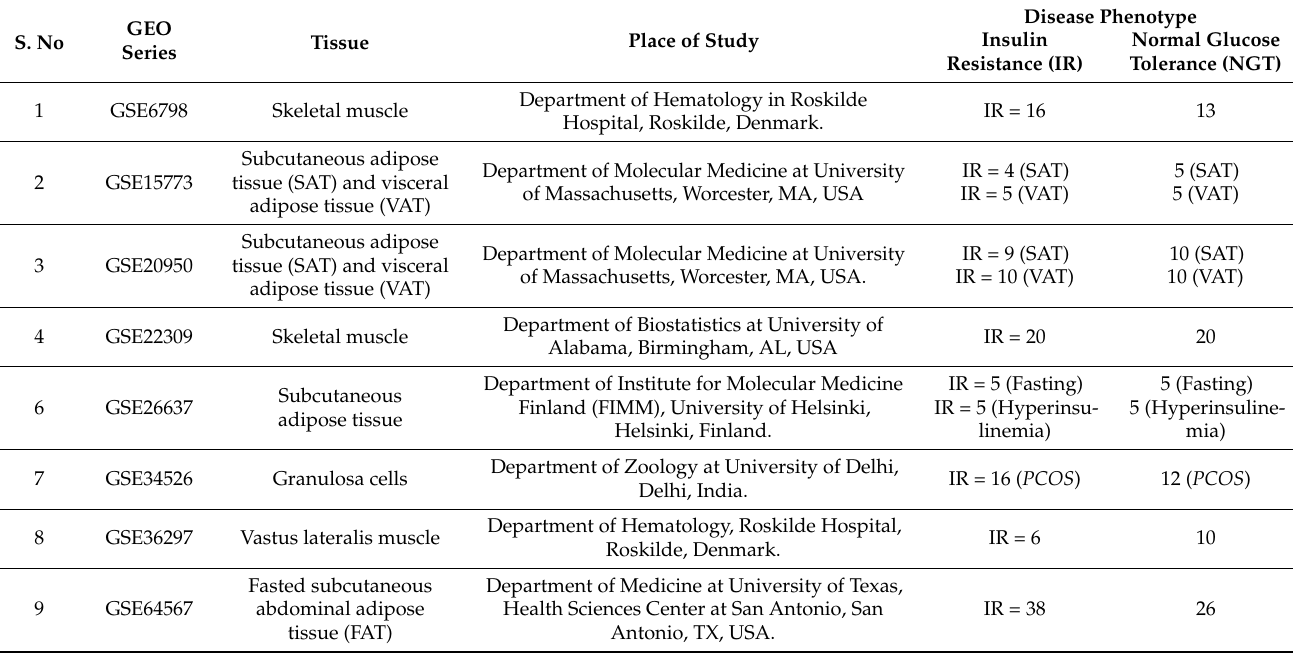
Table 1. Microarray samples used in meta-analysis for